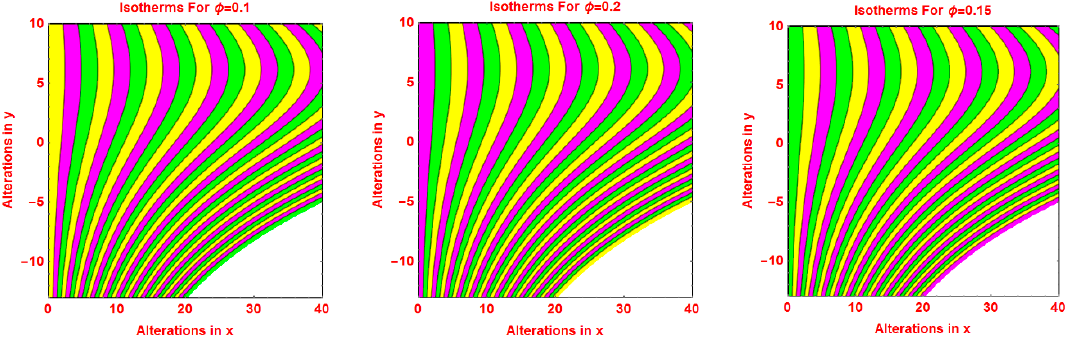
Figure 8. Effects of different values of ϕ on isotherms pattern.